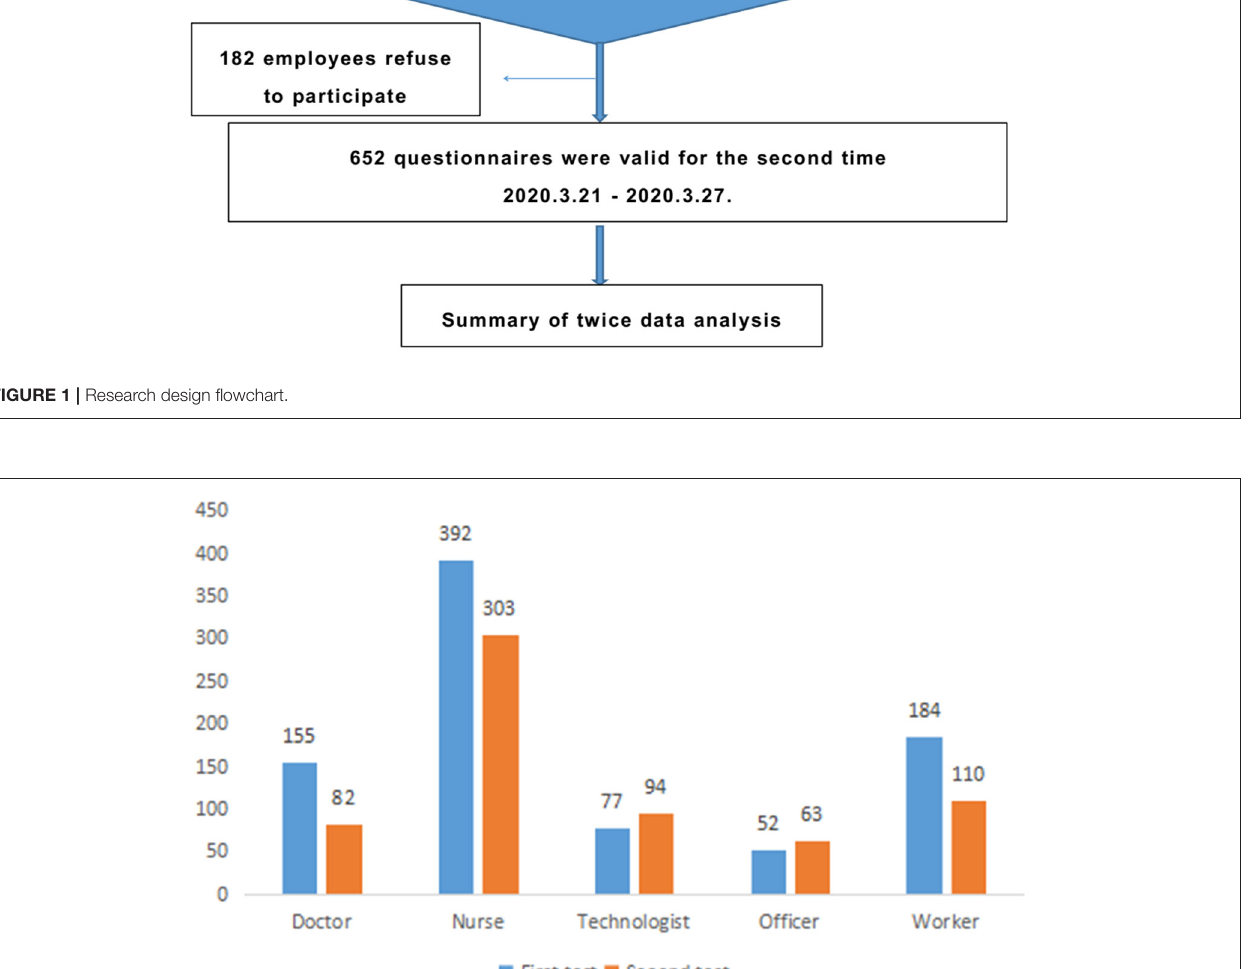
Frontiers in Public Health |